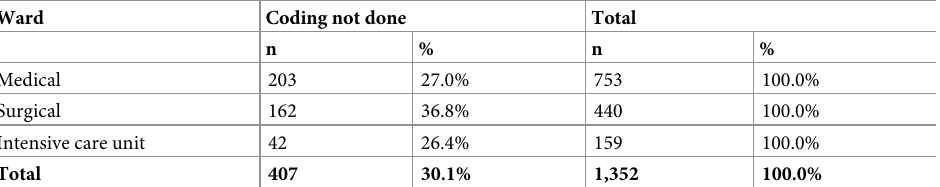
Table 7. Share of infection coding performed by ward